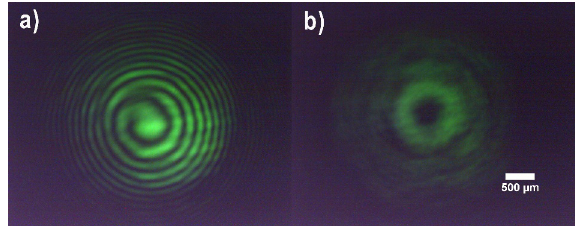
Figure 2. Interference pattern of the helical mode emerging from the diatom valve when illuminated by a LCP beam at λ = 532 nm, ( a ). Intensity distribution of the vortex obtained by blocking the reference beam ( b